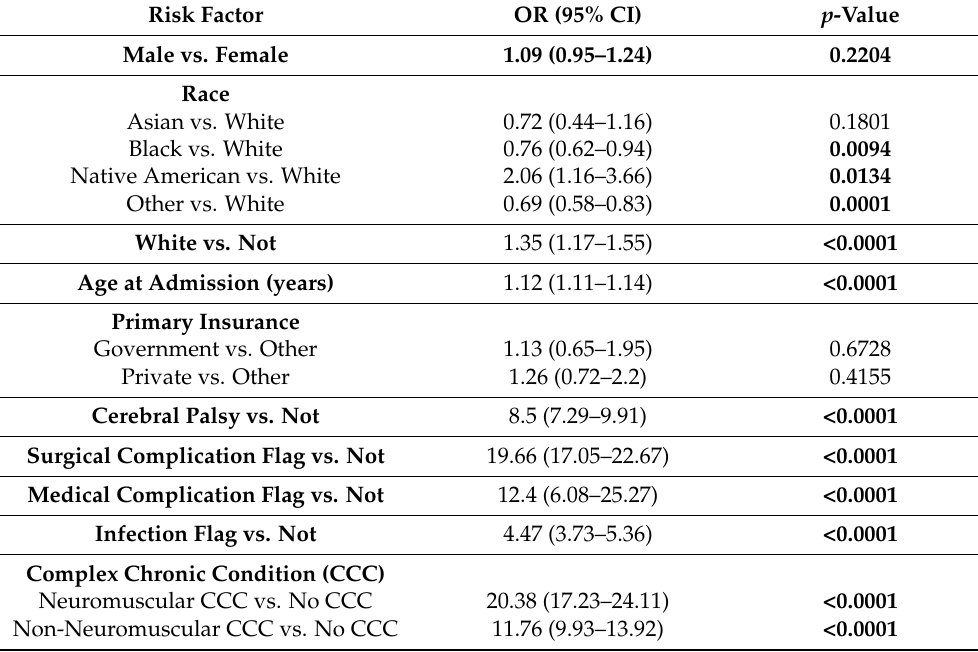
Table 3. Simple Logistic Analysis for Postoperative Urinary Retention.